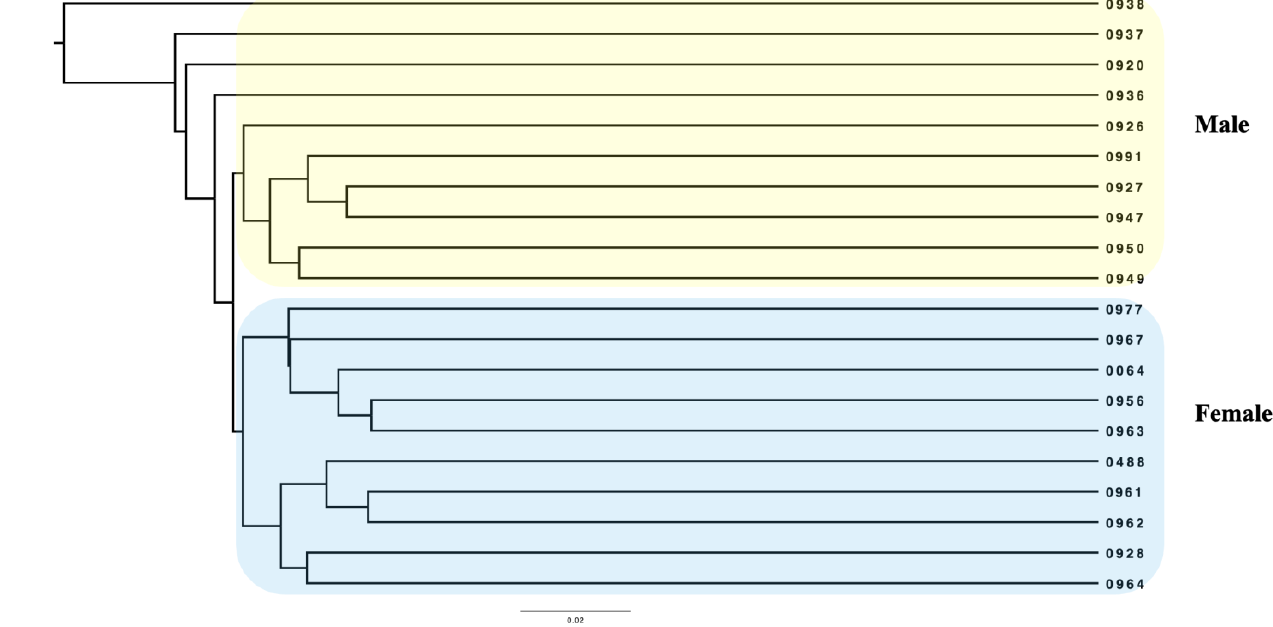
Figure 3. Dendrogram generated by UPGMA clustering analysis.